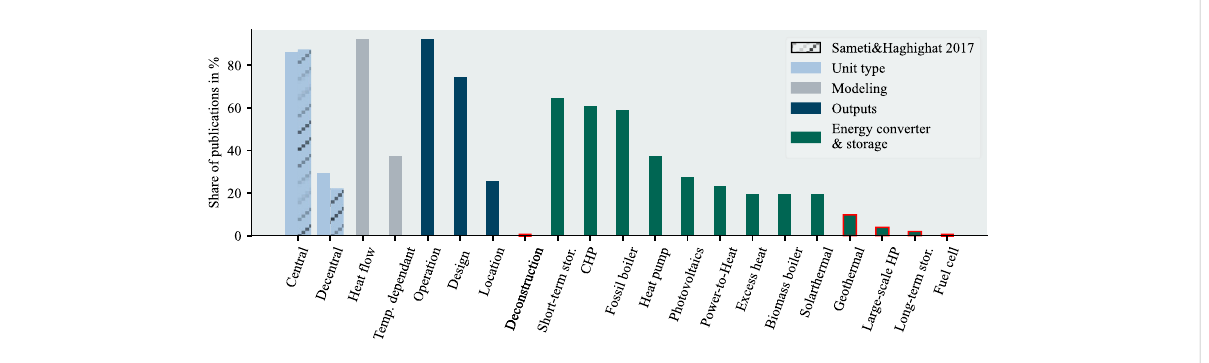
FIGURE 9 Literature distribution over the supercategory supply structure and the subcategories unit type, energy supply, modeling, outputs, and a comparison regarding the unit type with (Sameti and Haghighat, 2017); low numbers of publications ( < 15%) are marked red as an indication of a potential research